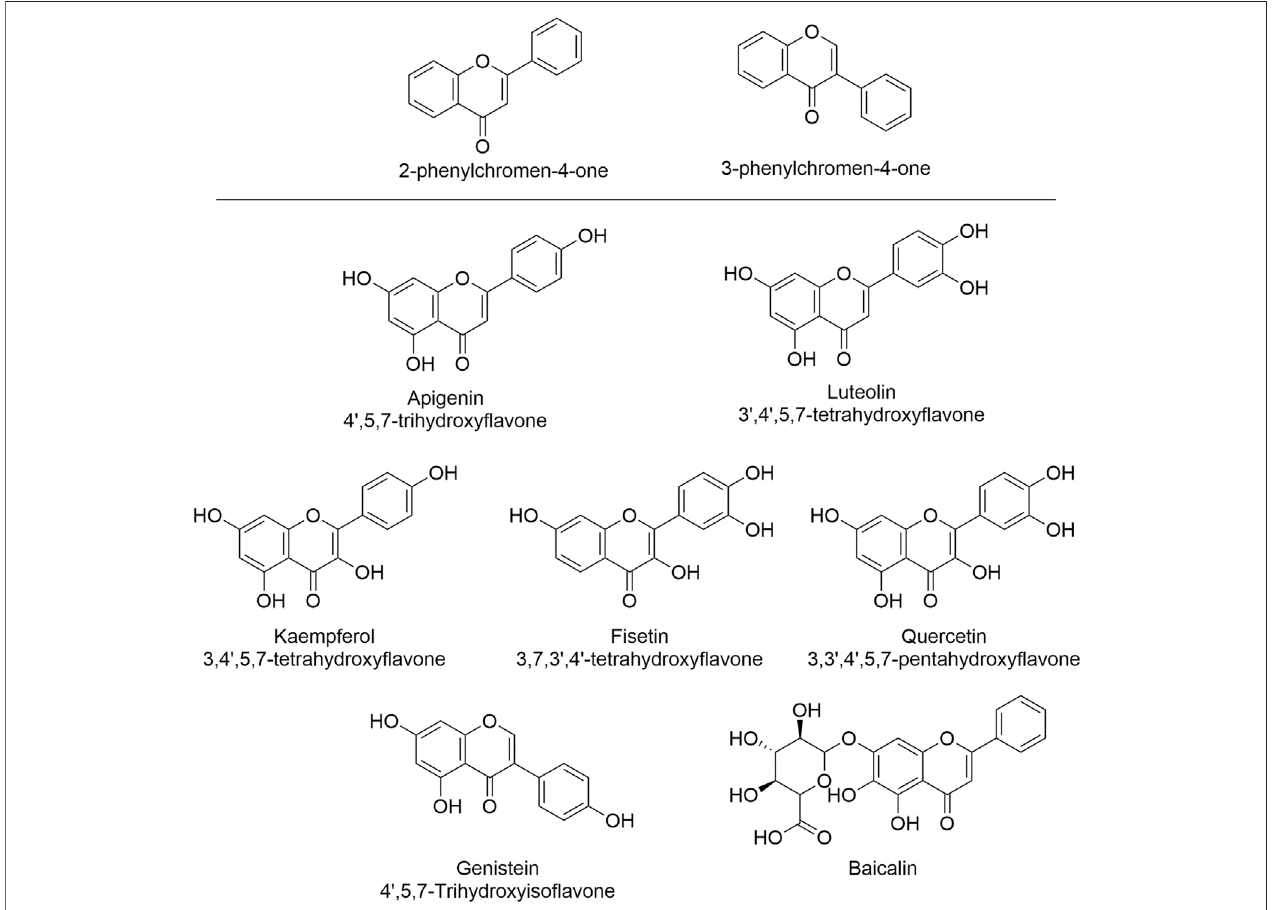
FIGURE 2 | The structures of fl avones and iso fl avone that show HF-treating/preventing effects via the regulation of both ROS and calcium signal. These natural products can serve as leading compounds that can undergo structural modi fi cation to achieve the selective regulation of ROS and calcium.